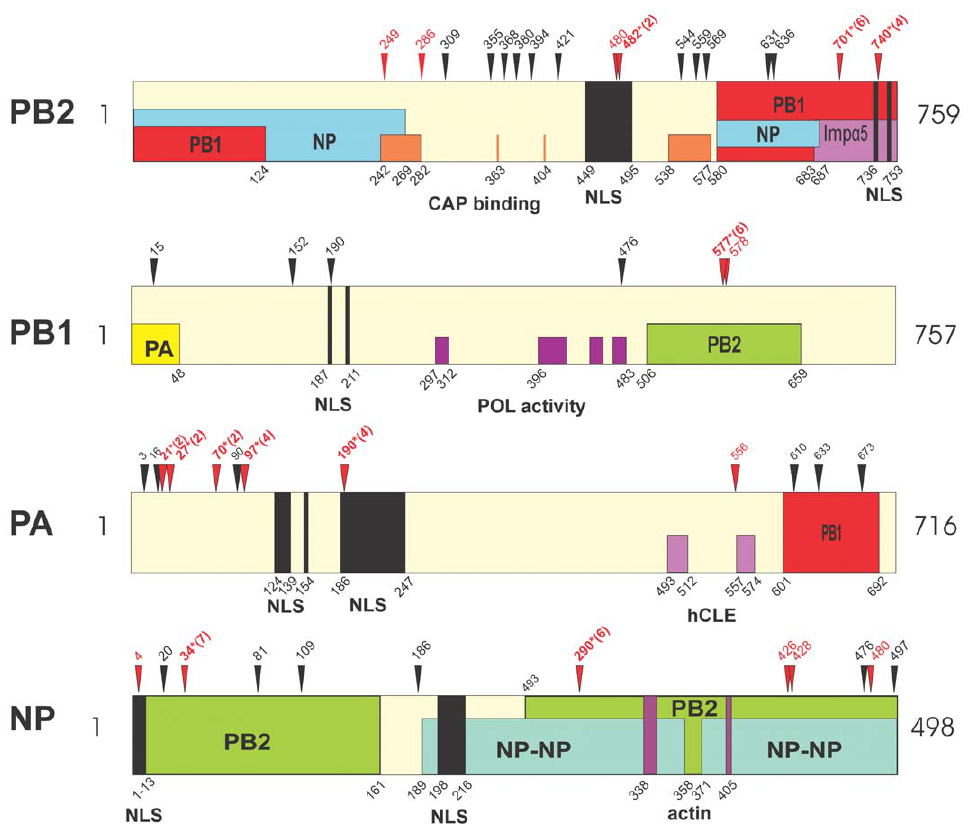
Figure 2. Mouse adaptive mutations on the primary structural maps of PB2, PB1, PA and NP proteins. The amino acid location of mutations are numbered and indicated with arrowheads on the linear sequence, sites of positive selection are shown red and parallel mutations are additionally indicated with an asterisk and the number of populations in parenthesis. The locations of regions of interaction, or functions are indicated with rectangles and are labeled with respect to interacting viral proteins as indicated in Methods. Nuclear localization signals (NLS) are in black, and host protein sites are indicated for PB2, PA and NP; PB1 polymerase activity regions are in purple and PB2 cap binding regions are in orange. hCLE, the human transcription factor is positioned In PA according to [124] The following mutations were mapped previously: PB2 D701N, PA Q556R, NP D34N, and NP D480N[59].